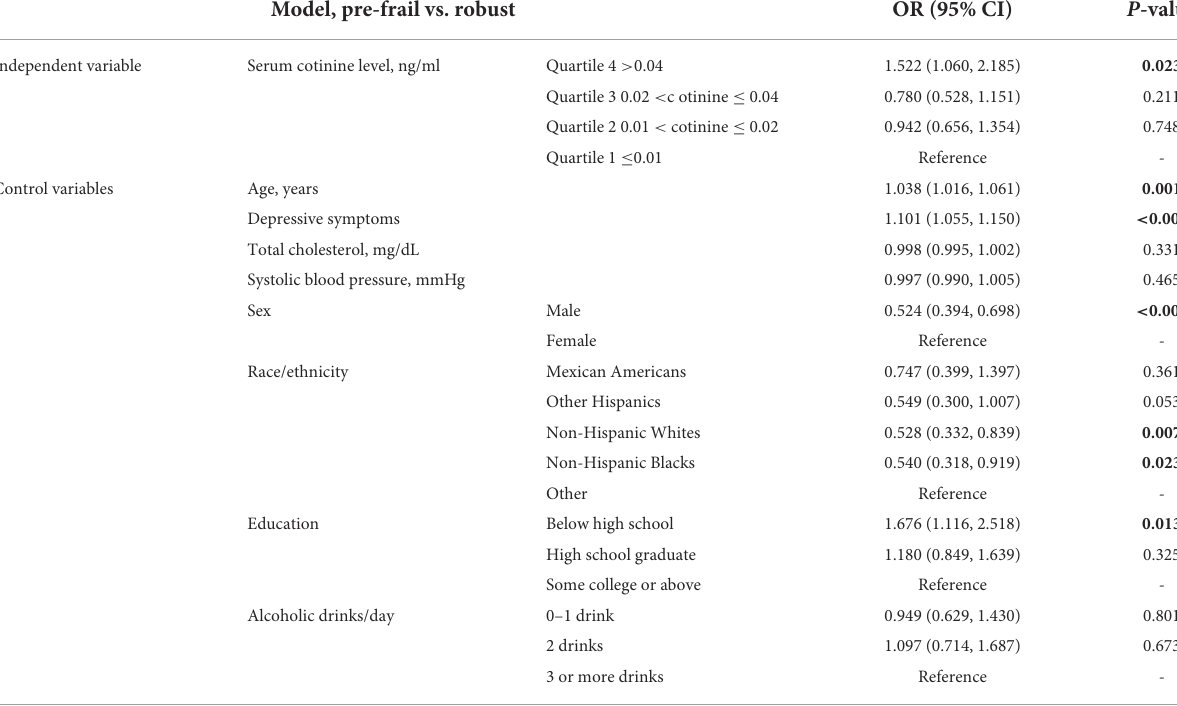
TABLE 2 The independent associations of serum cotinine level quartile (reference: ≤ 0.01ng/ml) with pre-frailty.